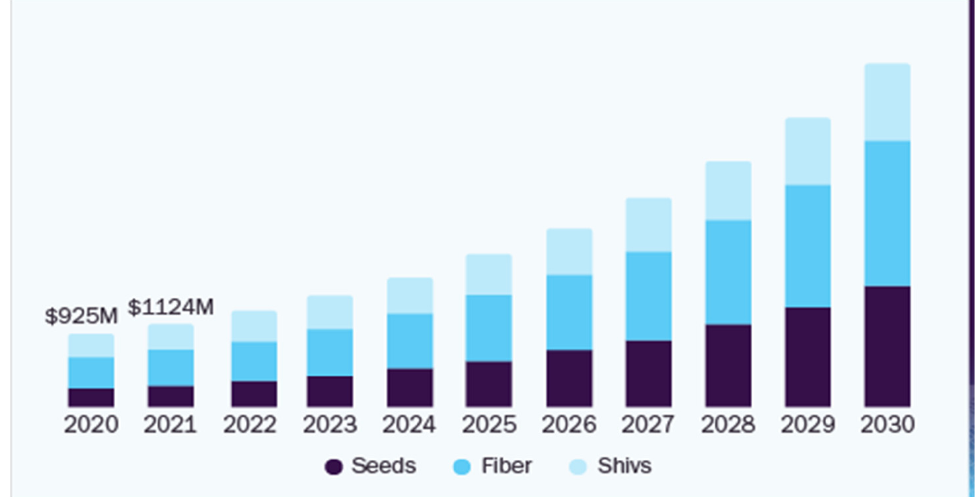
Figure 6. Size of U.S. Industrial Hemp Market by Product, 2020–2030 (USD Millions). Source: https://www.grandviewresearch.com/industry-analysis/industrial-hemp-market (accessed on 20 February 2023).